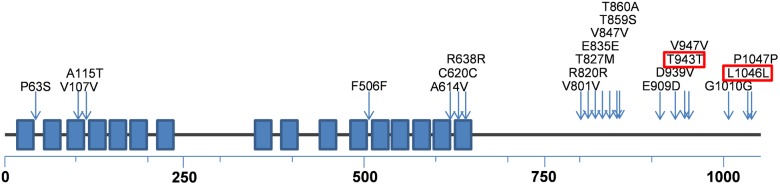
Schematic representation of ZNF628 with locations of SNPs used in gene-based rare allele analysis in this study.
ZNF628 is a protein 1059 amino acids long. We briefly showed the domains (boxes) and the locations of SNPs (arrows) in a schematic linear structure of ZNF628. Blue boxes denote C2H2-type zinc finger domains. dbSNP ID can be found in Table S2 in File S1. SNPs within red boxes were used in the second analysis.